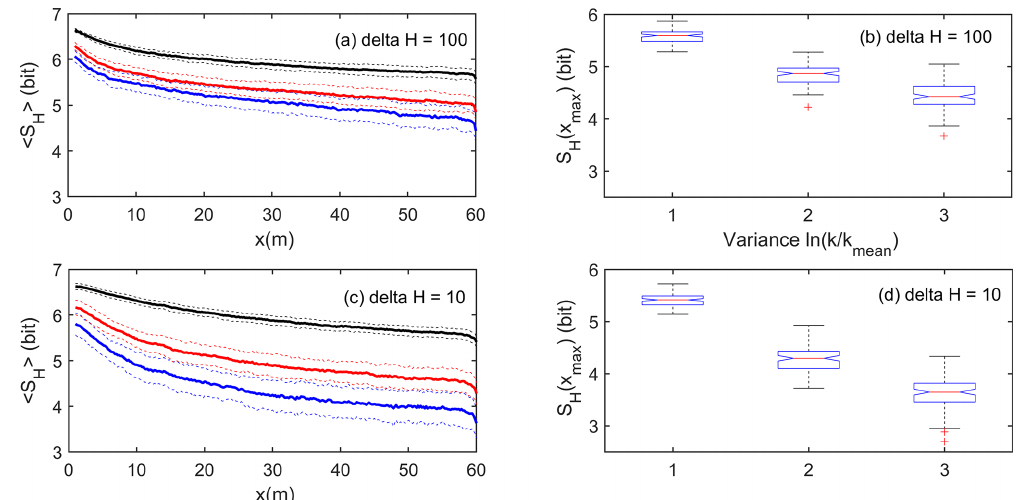
Figure 3. Flow path entropy averaged across all 100 ensemble realizations <S H > as a function of downstream transport distance for (a) (cid:49)H = 100m and (b) (cid:49)H = 10m; the dashed lines mark the range plus/minus the standard deviations. Boxplot of flow path entropy at the domain outlet for all realizations of the three variance cases for (c) (cid:49)H = 100m and (d) (cid:49)H = 10m; note this corresponds to the asymptotic values in (a) at x =